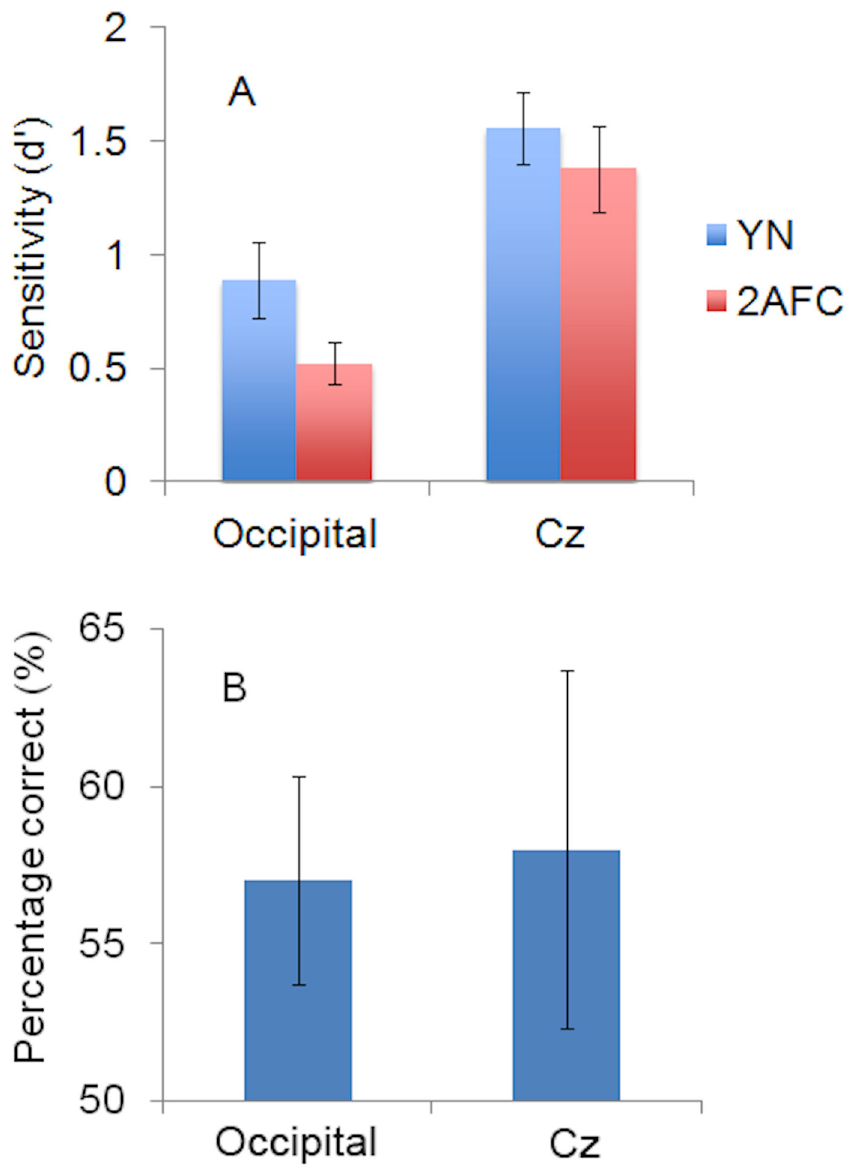
Figure 2. Evidence for TMS-induced Unconscious Vision. A . Visual sensitivity under Yes-No (YN) and Forced-Choice (FC) response conditions during TMS stimulation of Occipital Cortex and Cz. B . Percentage of correct orientation judgments on miss trials during TMS stimulation of Occipital Cortex and Cz. Vertical bars show the standard error of the mean.